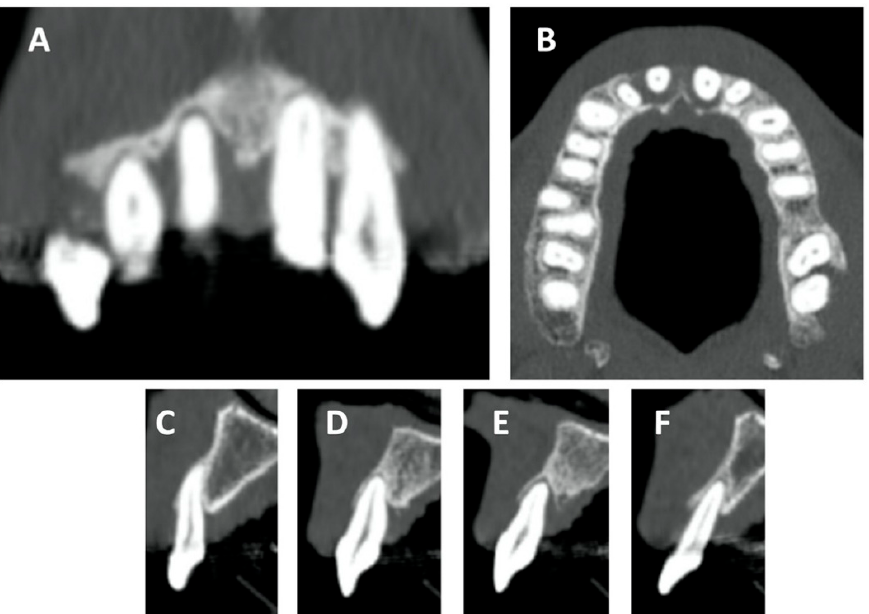
Figure 2. Details obtained from CBCT: ( A ) superior incisor coronal view, ( B ) superior incisor axial view, and ( C – F ) superior incisor sagittal view. Diffused radiolucent areas suggest a low grade of bone attachment, particularly in the area of the superior incisors.